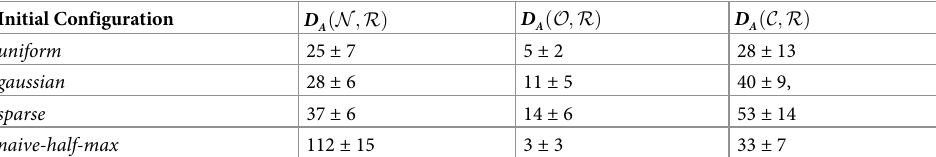
Table 4. Aggregate distance measures for each of the 4 initial network configurations. Mean and standard deviation reported for 30